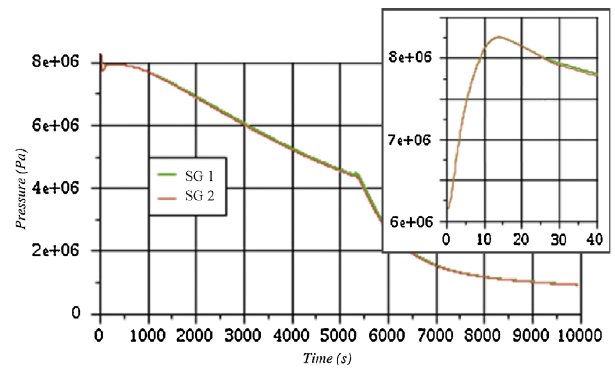
Fig. 10. Secondary pressure (Pa) with focus on fi rst 40 s.